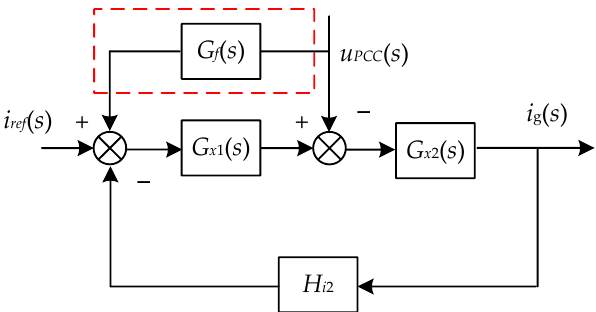
Figure 19. The resonance suppression strategy with PCC voltage feedforward.